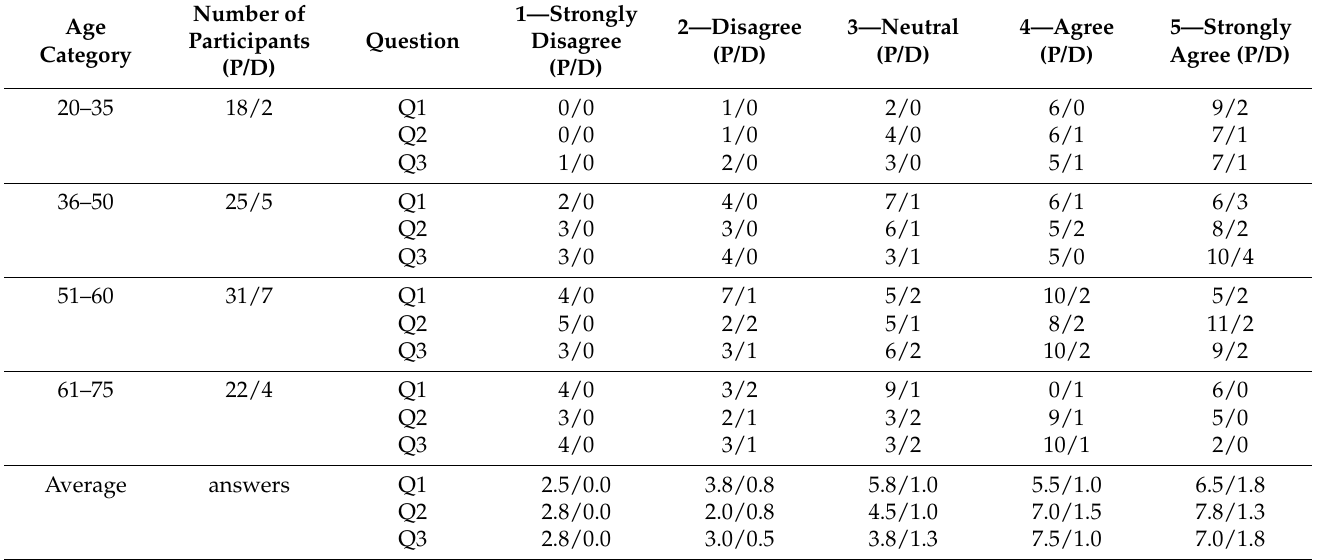
Table 1. The results of the survey regarding the potential patients/users and doctors based on age categories and the answers replied to the questions.